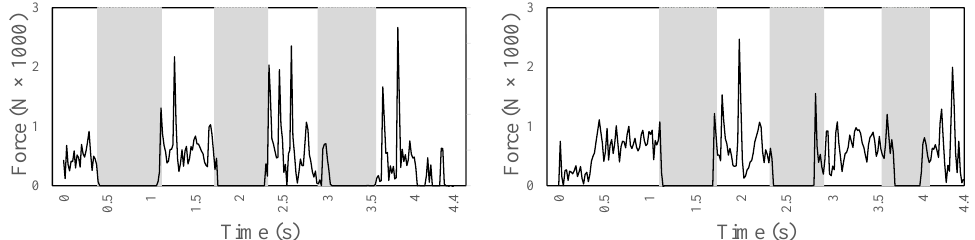
Figure 12. The ground reaction force in the Y direction computed at the zero moment point of each foot (left foot on the left and right foot on the right) during ramp